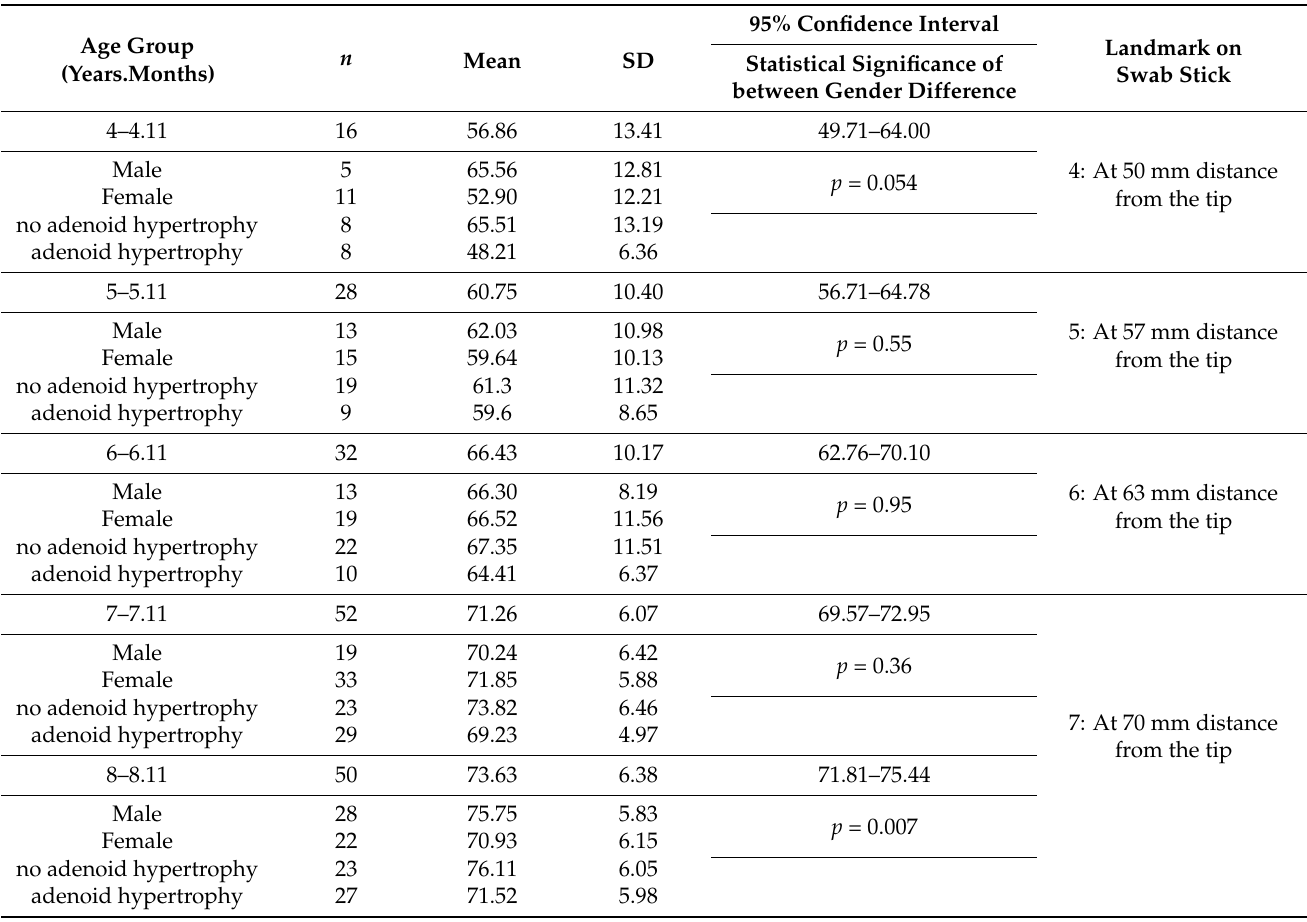
Table 1. Descriptive statistics of the nostril to nasopharynx distance (mm) according to age, gender, and adenoid hypertrophy.